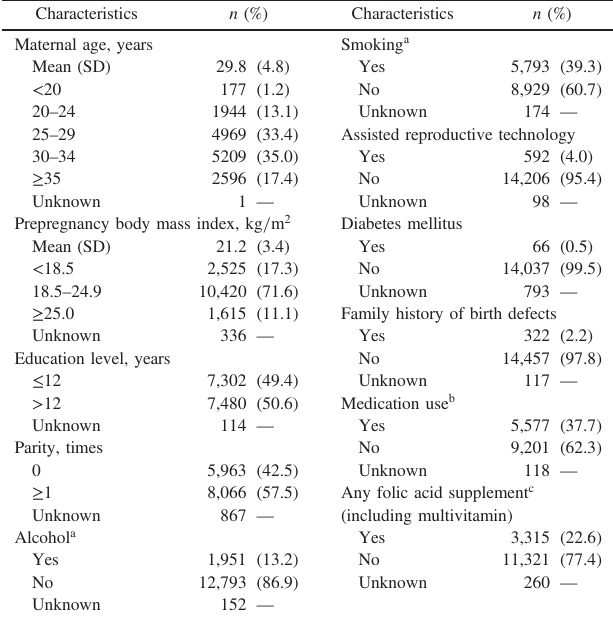
Table 1. Baseline characteristics of participants ( n = 14,896)